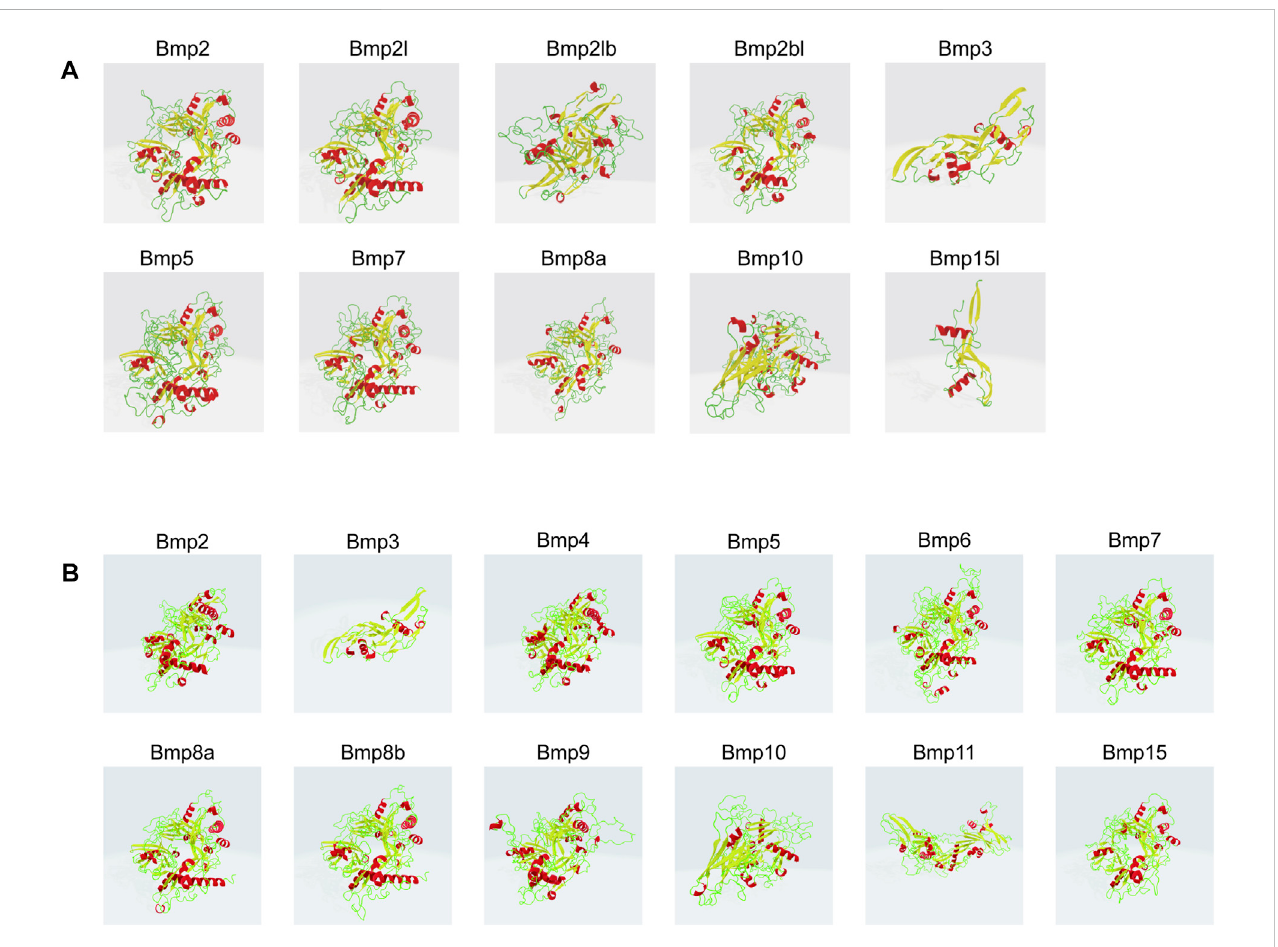
FIGURE 8 Three-dimensionalmodelingofBMPproteinsin P . sinensis (A) and Homo (B) .Redindicatesalphahelix,yellowrepresentsbetaturn,greenshowsrandom